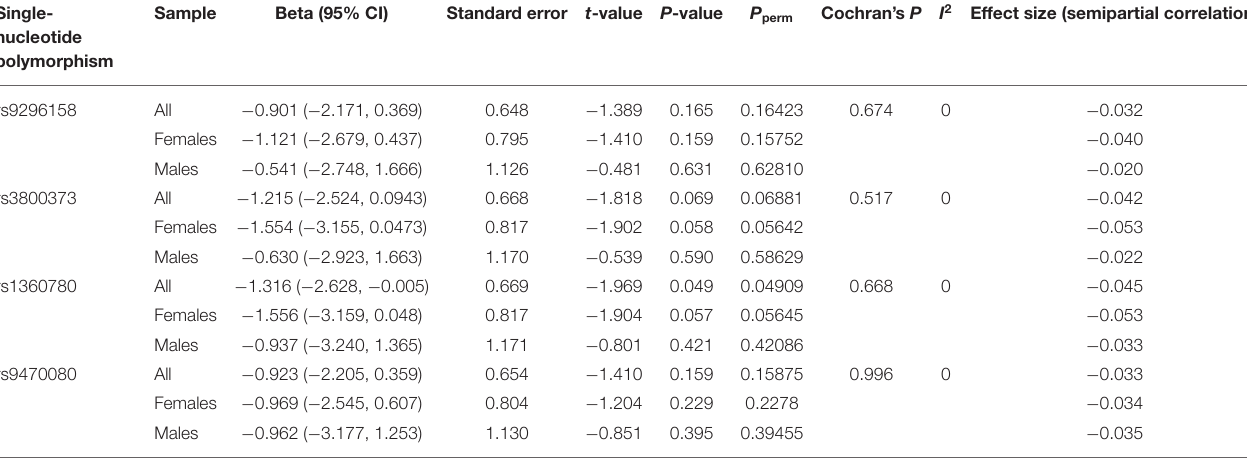
TABLE 2 | G × G effects of ADCYAP1R1 – FKBP5 (rs2267735 × rs9296158, rs3800373, rs1360780, and rs9470080) on posttraumatic stress disorder severity. Single- nucleotide